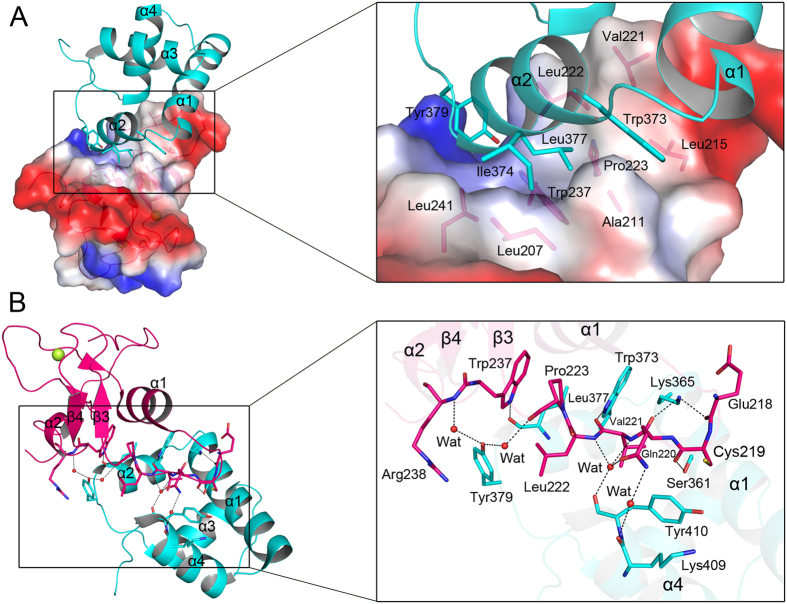
The Slx1RING-Slx4CCD complex interface.(A) Detailed representation of complex interface involved in hydrophobic interactions. Slx4CCD is shown as cartoon diagram colored in cyan, and Slx1RING is indicated as cartoon diagram colored in pink and translucent electrostatic surface potential representations. The involved residues are shown as sticks. (B) Detailed representation of complex interface involved in hydrogen bonds. Slx1RING and Slx4CCD are colored in pink and cyan, respectively. The involved residues are shown as sticks. Water molecules are shown as red balls.